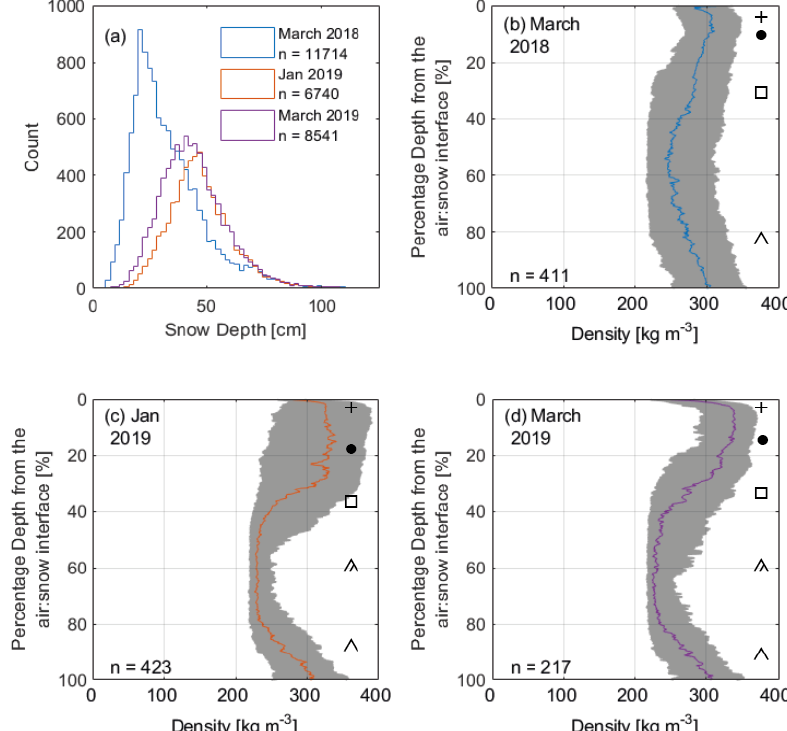
Figure 3. Distributions of measured layer densities (SS: surface snow, WS: wind slab, DH: depth hoar) from four sampling campaigns: box (interquartile range), blue line (median) and whiskers (dashed lines) extend from the end of each box to 1.5 times the interquartile range; blue crosses represent outliers beyond this range.